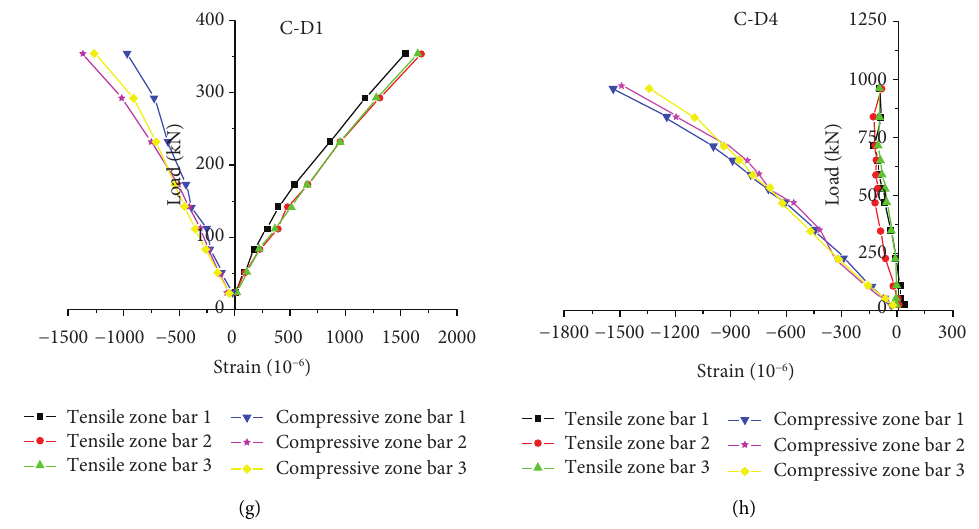
Figure 8: Load-longitudinal reinforcement strain curve of the specimen.